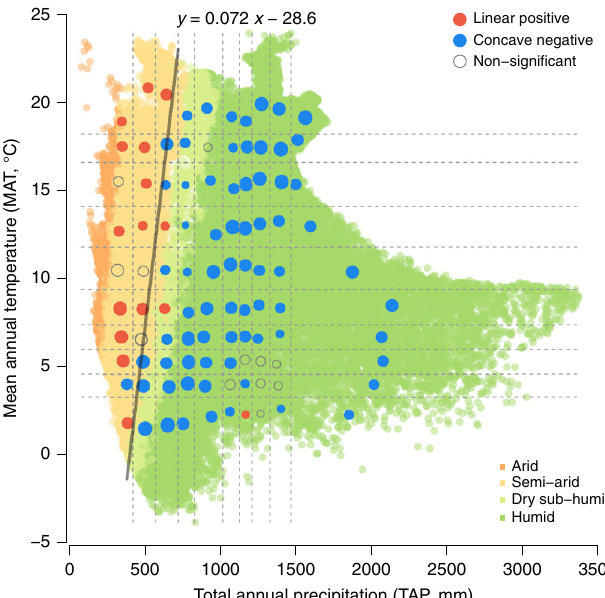
Fig. 1 Relationship between tree richness and productivity in different climatic units. The color of circles within each climatic unit indicates the form of the relationship determined by a generalized linear model between biodiversity and productivity, and circle radius is proportional to the number of forest plots (log-transformed) in each climatic unit. Forest plots were divided into 10 × 10 climatic units according to their MAT and TAP quantile classes based on WorldClim 25 ; and are colored according to their aridity index (0.03 – 0.2, arid; 0.2 – 0.5, semi-arid; 0.5 – 0.65, dry sub-humid; > 0.65, humid) based on the Global Aridity Index 26 . The line between the red and blue points is the division between the linear-positive and concave-negative relationships based on a logistic regression for the two groups as a function of MAT and